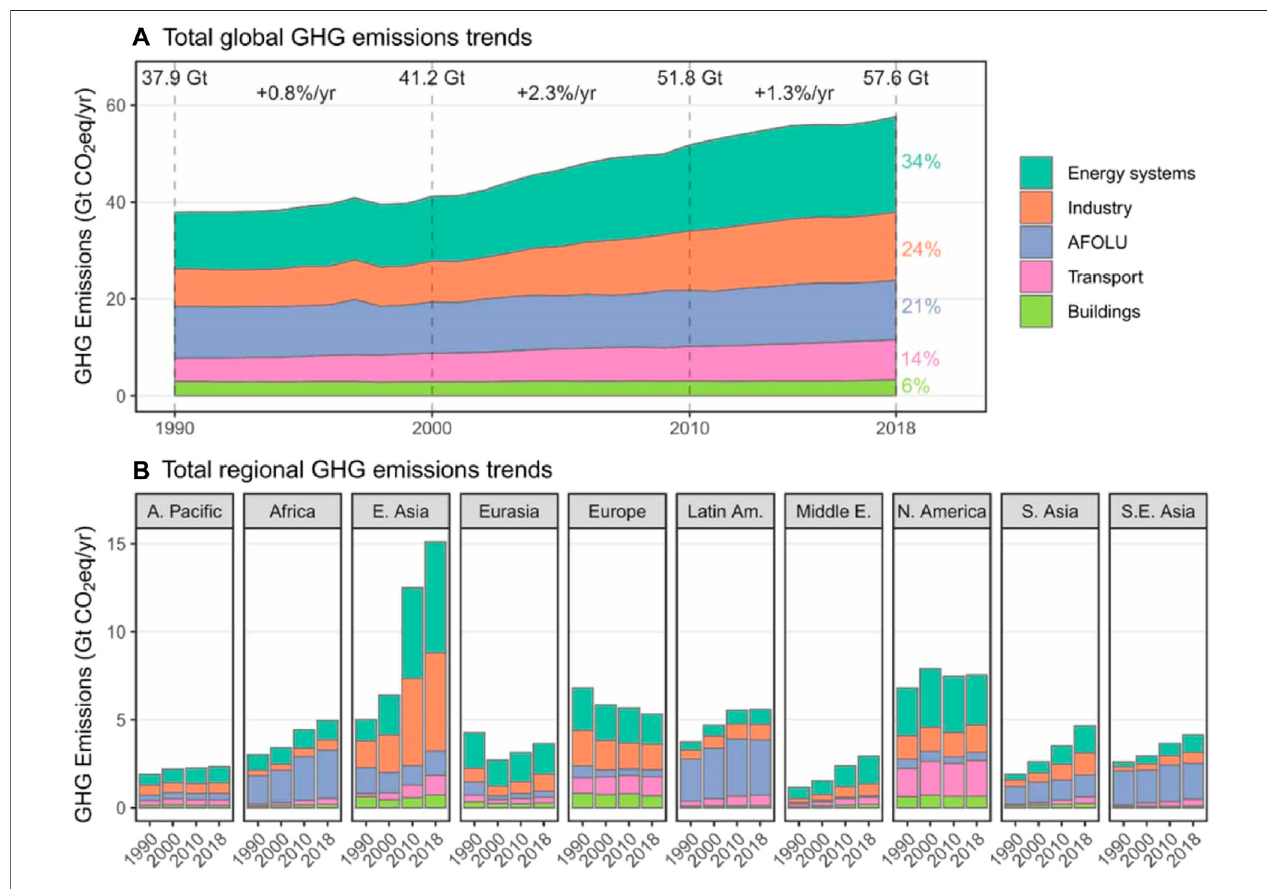
FIGURE 2 | Greenhouse gas contribution by economic sector (Boden et al., 2017; Lamb et al., 2021).